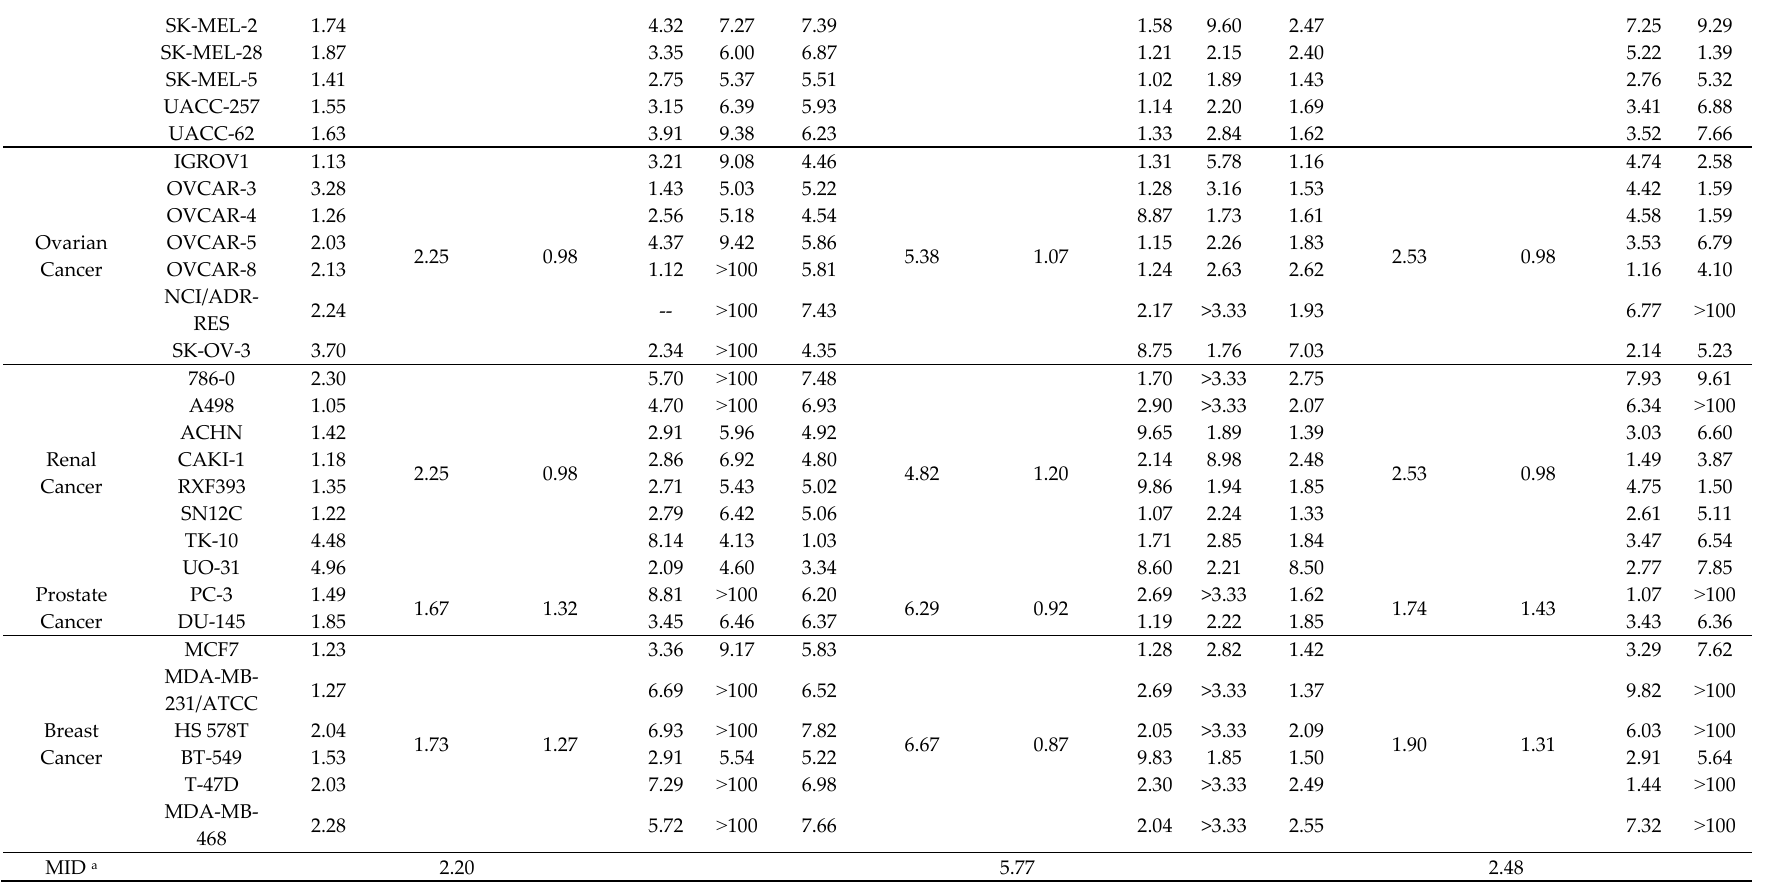
MID a = Average sensitivity of all cell lines in mM and MID b = average sensitivity of all cell lines of a particular subpanel in μ